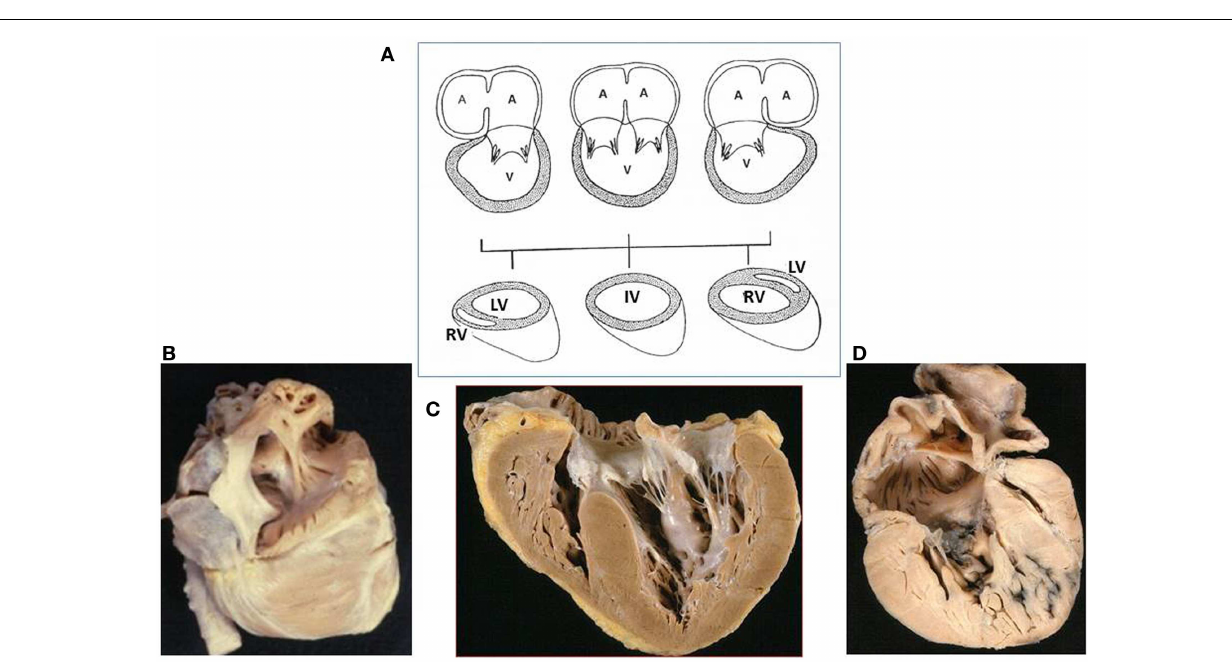
FIGURE 2 | Univentricular atrioventricular connection . (A) The atrioventricular connection is univentricular when both atria drain mostly into a single ventricular chamber through two patent or a common atrioventricular valves (double inlet connection) or through a single valve in case of absent right or left connection. Note the anterior position of the right ventricle and the posterior position of the left ventricle when the main chamber is of left or right morphology, respectively. In the absence of ventricular septum, the main ventricular chamber is of indeterminate morphology (IV). (B) . Absent right